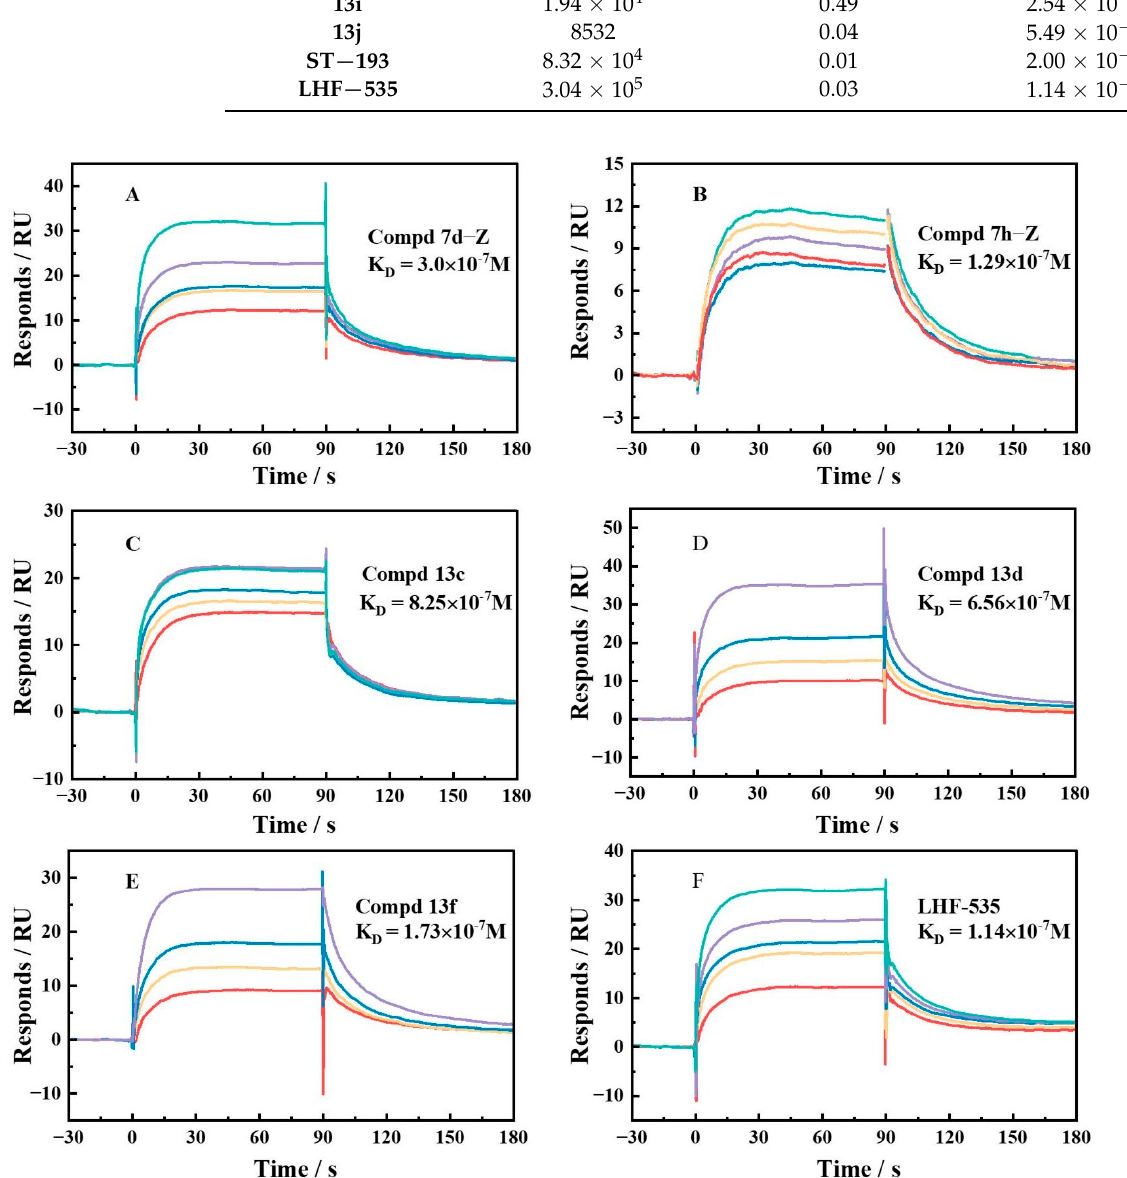
Figure 4. Binding sensory plots of representative compounds ( A ) 7d − Z , ( B ) 7h − Z , ( C ) 13c , ( D ) 13d , ( E ) 13f , and ( F ) LHF − 535 interacting with immobilized GP2. Table 3. The SPR data for the binding of active compounds. Compd.